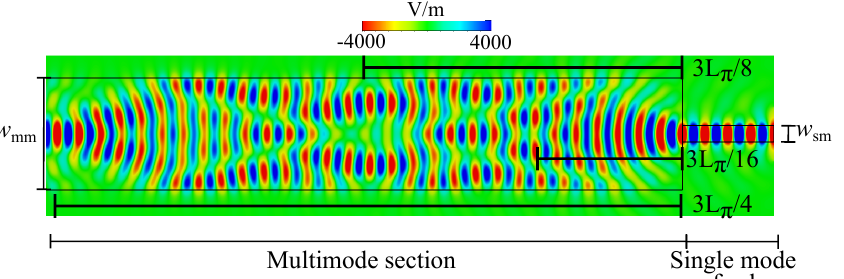
Figure 33. Field distribution in a multimode waveguide centrally fed by a single mode waveguide at 92.5GHz. w sm = 1.8mm, w mm = 12.25mm, ε r = 2.53. Relevant lengths for explicit number of maxima are